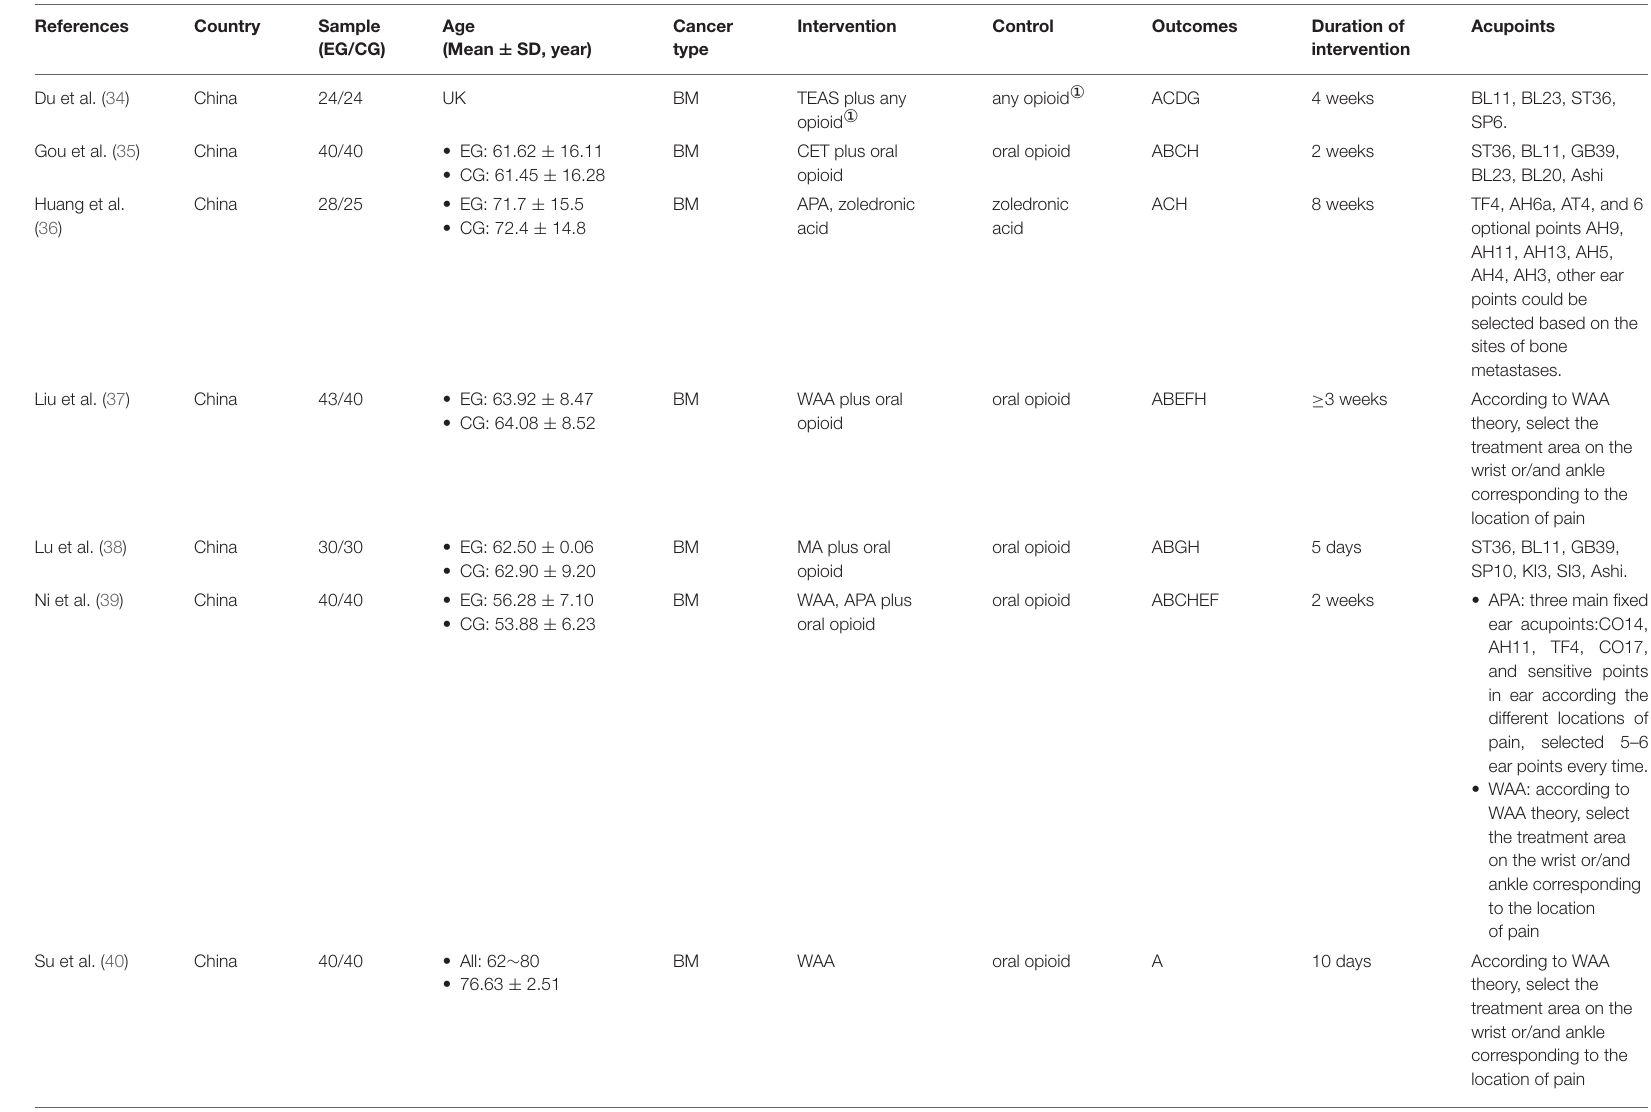
TABLE 2 | Characters of the included